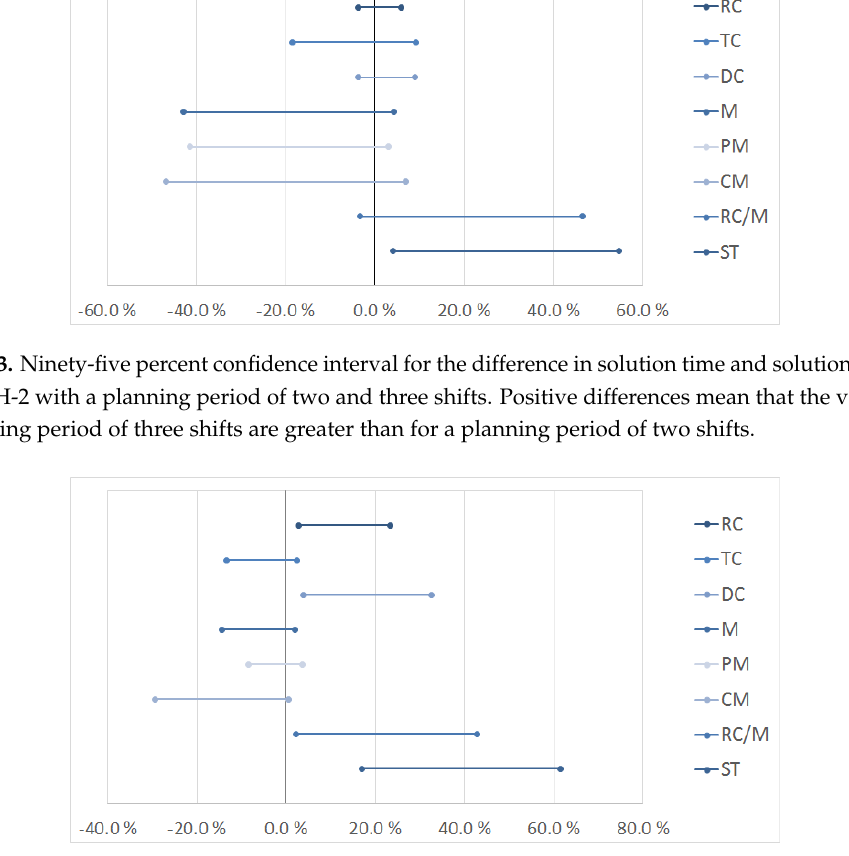
Figure 4. Ninety-five percent confidence interval for the difference in solution time and solution quality of RHH-2 with a planning period of two shifts and the exact model with a planning period of one shift. Positive differences mean that the values of a planning period of RHH-2 with two shifts are greater than for the exact model with one